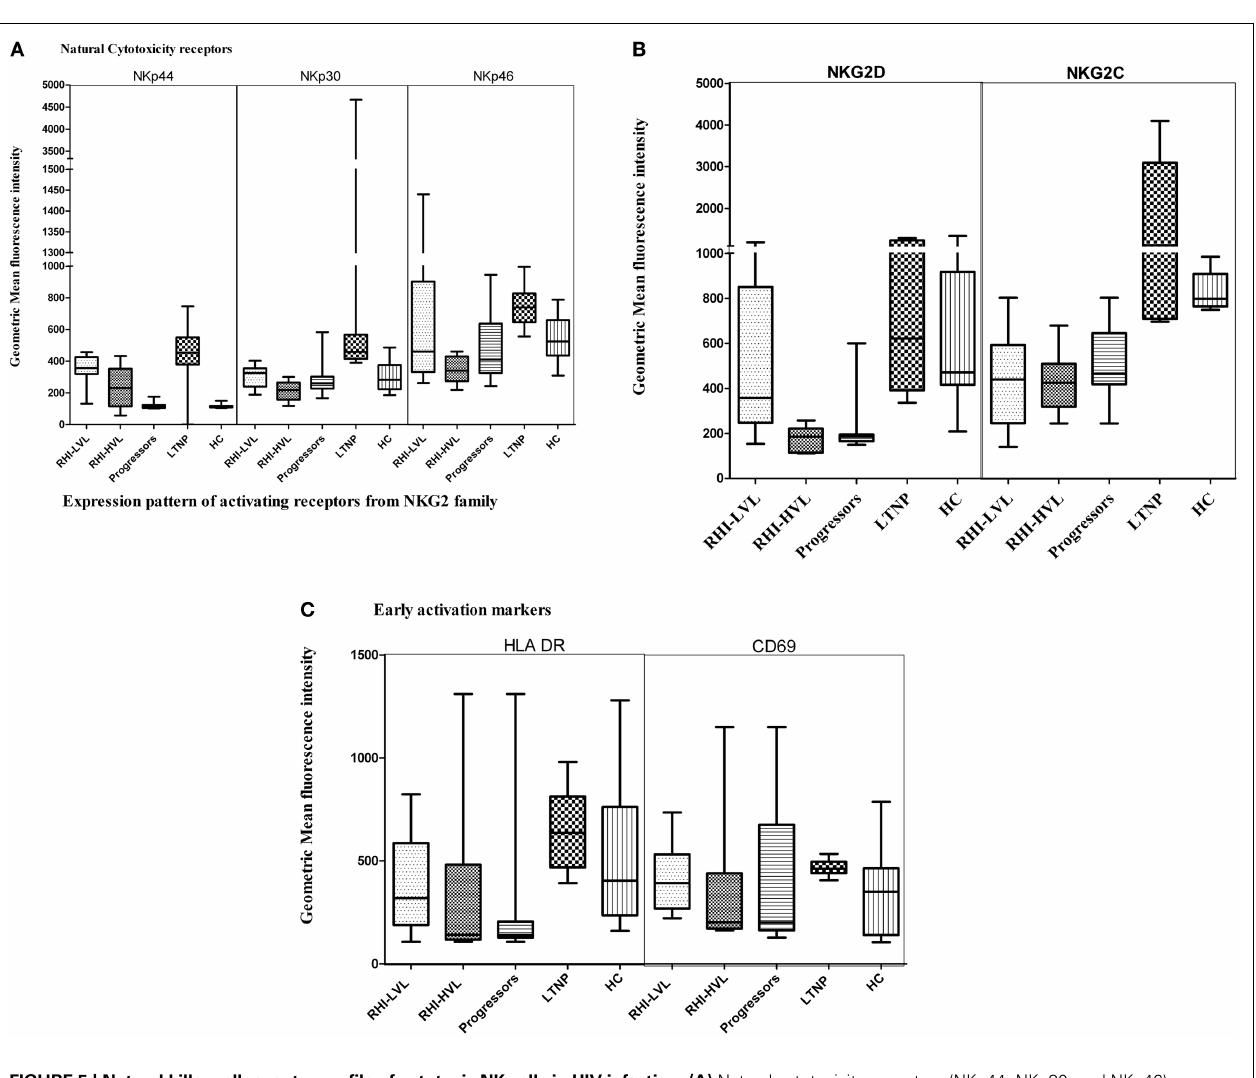
FIGURE 5 | Natural killer cell receptor profile of cytotoxic NK cells in HIV infection . (A) Natural cytotoxicity receptors (NKp44, NKp30, and NKp46), (B) activating receptors: NKG2D and NKG2C, and (C) early activation receptors HLA-DR and